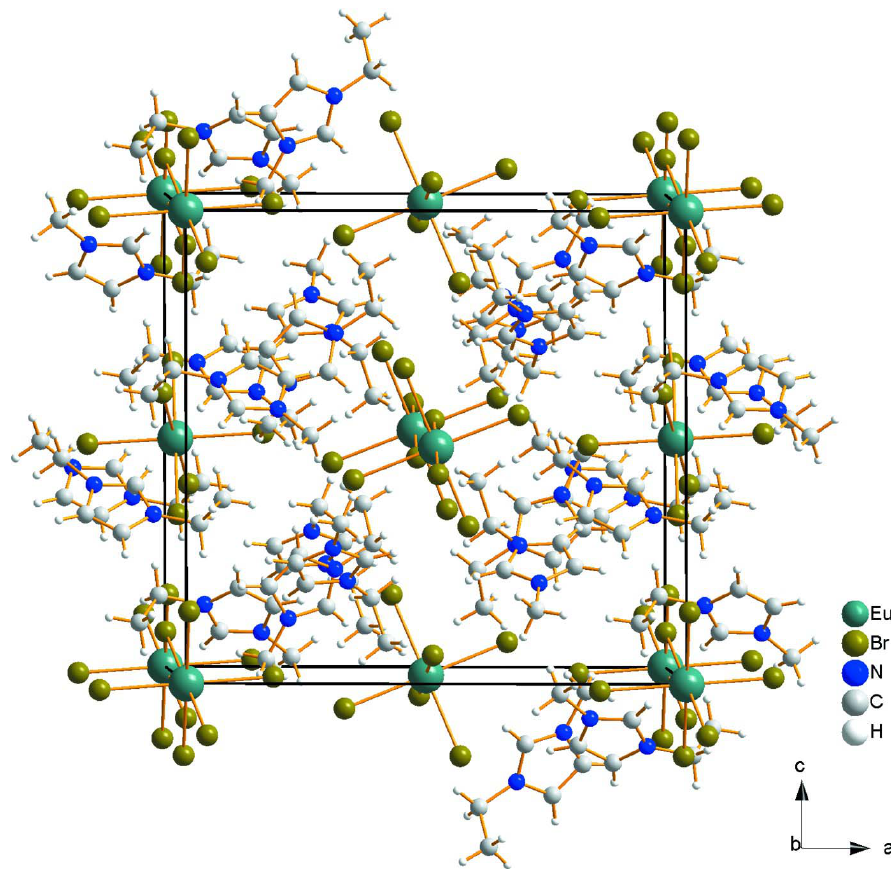
] 3- anions are located on the corners and 6